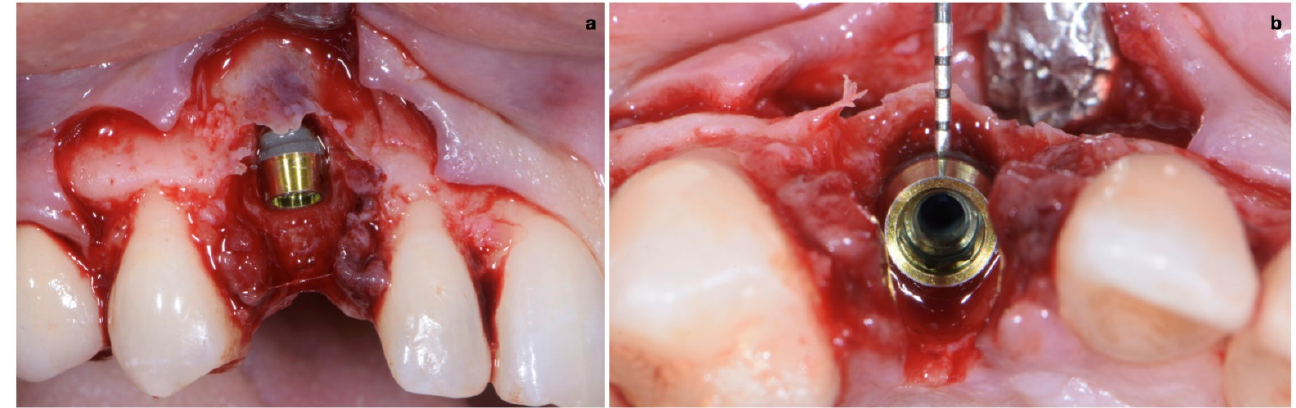
Figure 6. ( a , b ) Implant placement after guided preparation of implant site.